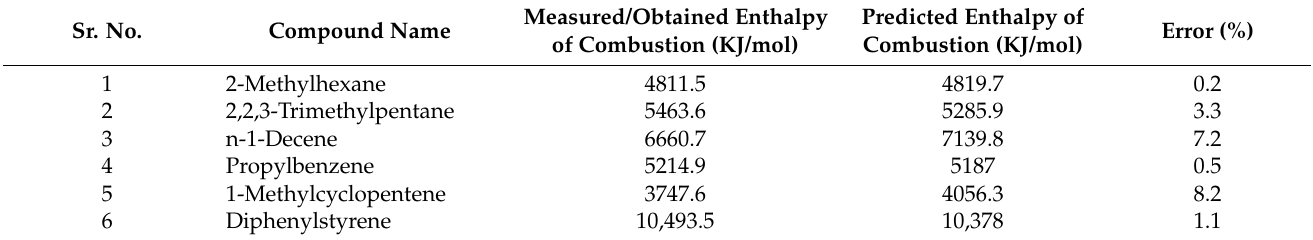
Figure 19. The best obtained result of training the dataset in a neural network. Table 3. Comparison between the measured enthalpies and the predicted ones .